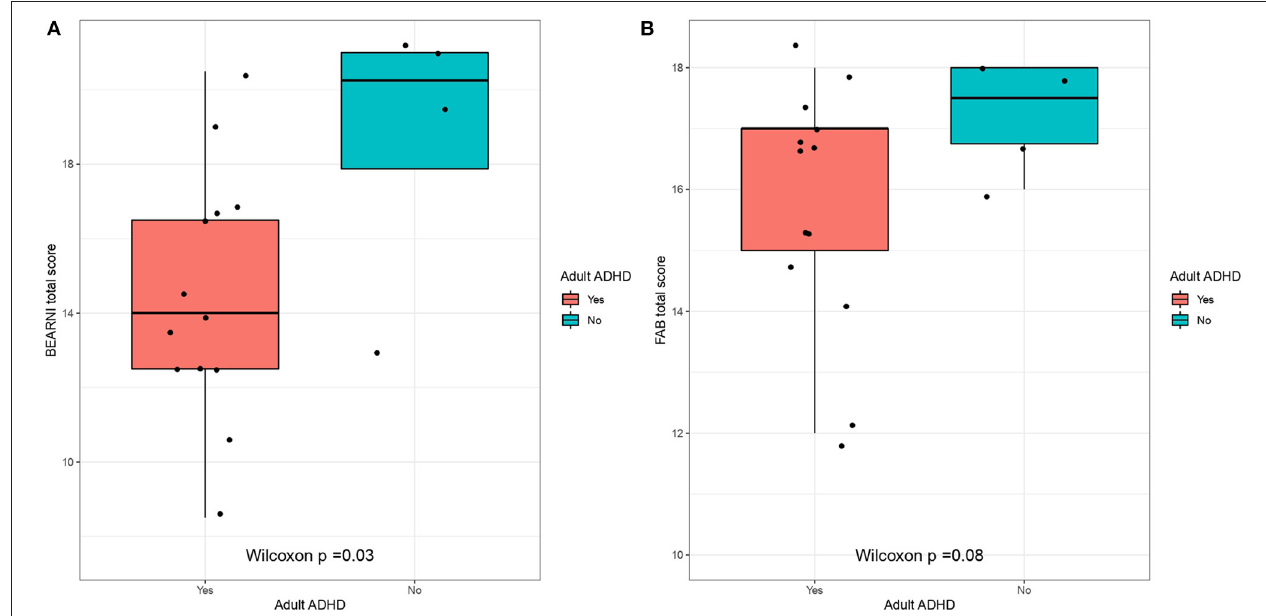
FIGURE 3 | Neurocognitive scores as a function of ADHD. ADHD measured by the DIVA-5, neurocognitive profiles measured by (A) BEARNI and (B) FAB. BEARNI, Brief Evaluation for Alcohol Related Neuropsychological Impairment; FAB, Frontal Assessment Battery; DIVA, Diagnostic Interview for ADHD in